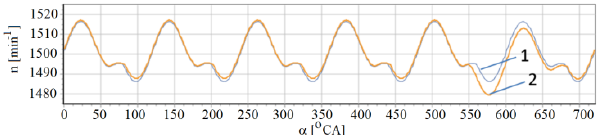
Fig. 2. The rotational speed of the generator rotor as a function of an angle of rotation of an engines crankshaft for: 1 – for an operational engine, 2 – for a damaged engine (reducing the dose of fuel supplied to the No. 1 cylinder by 50%) The direct cause of rotation speed fluctuation of a ge- nerator rotor are the rotational speed fluctuations of an engine crankshaft. They result from the variable torque of a crankshaft and depend on the value of indicated pressure in the engine cylinders [7]. Figure 3 shows the torque curve obtained in the result of modelling for the six-cylinder engine 1 – operational, 2 – damaged.